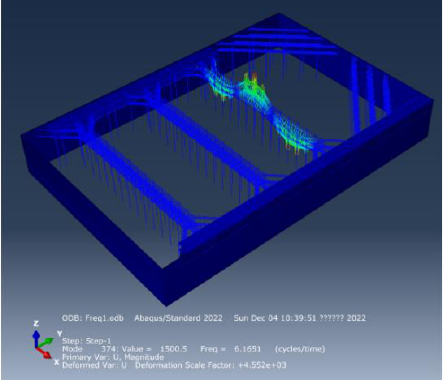
Figure 5. Vertical first-order vibration mode (6.16 Hz).